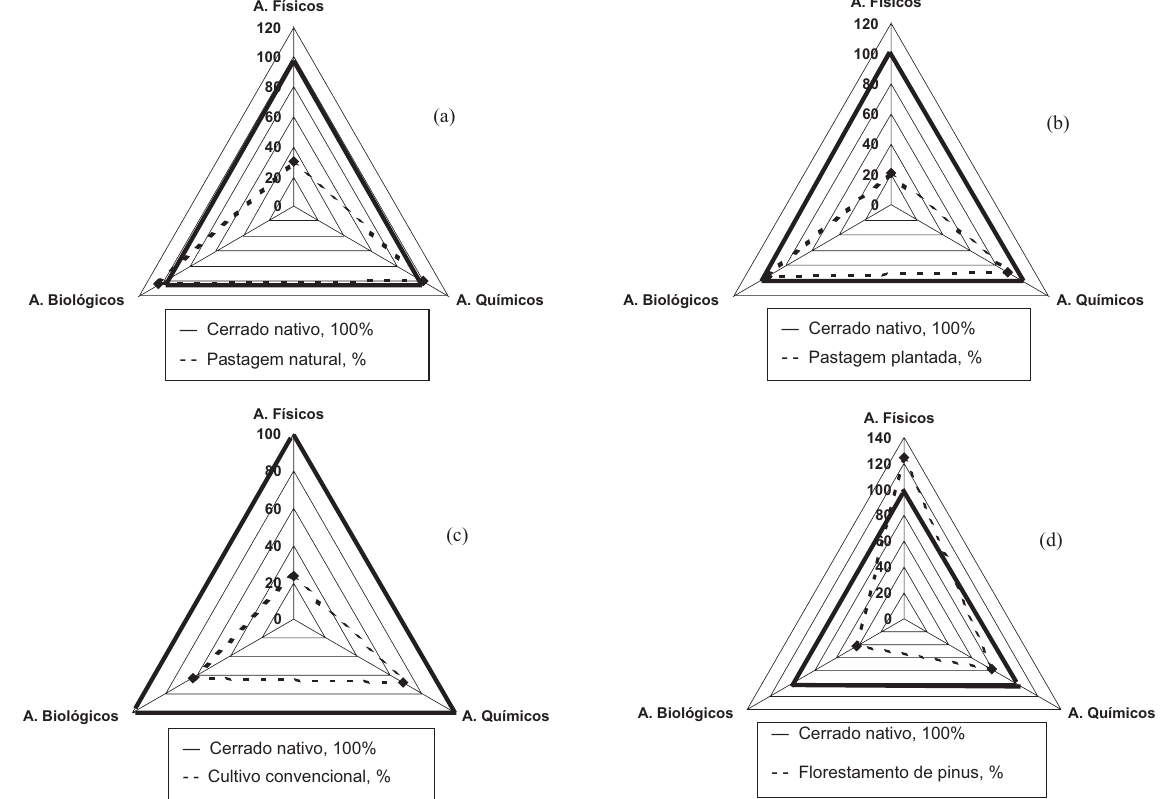
Figura 1. Diagramas comparativos da qualidade do solo, distribuída em atributos físicos, químicos e biológicos, em relação ao Cerrado nativo, considerando apenas a camada de 0 a 5 cm das seguintes áreas: (a) pastagem natural, (b) pastagem plantada, (c) cultivo convencional e (d) florestamento de